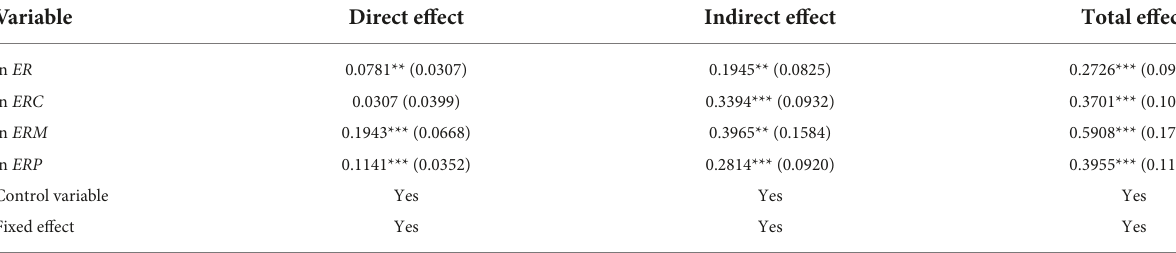
TABLE 12 Decomposition results of spatial